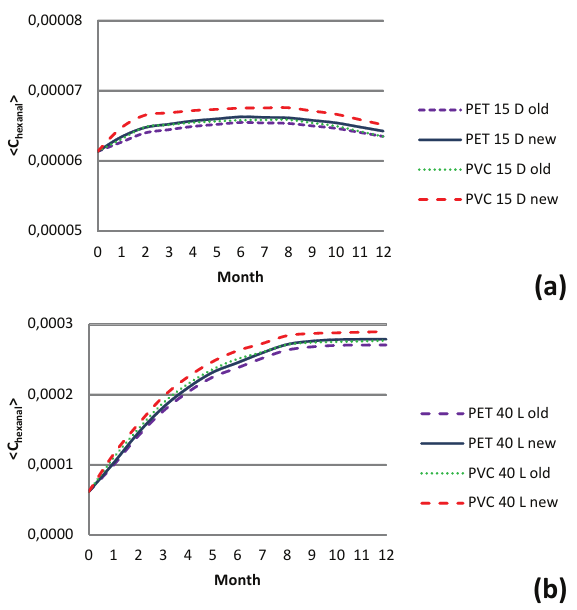
Figure 1: Effect of convection on the hexanal concentration for the “best” (a) and the “worst” (b) case.